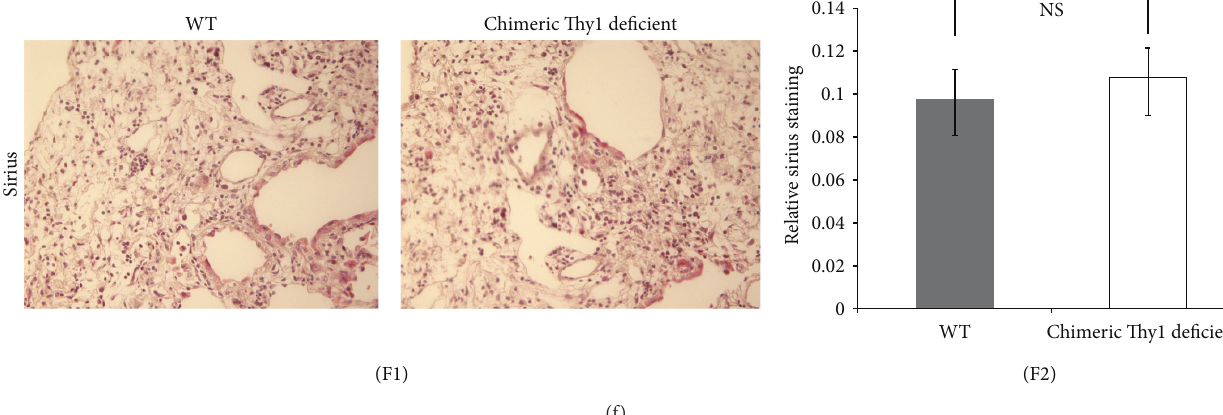
Figure 3: Assessment of fibrotic lung injury following bleomycin intratracheal instillation (IT) in wild-type mice with Thy1 + lymphocytes and Thy1 + myofibroblasts (WT), and chimeric Thy1-deficient mice with Thy1 + WT lymphocytes and Thy1 − myofibroblasts (chimeric). Thy1- deficient mice (DEF) were provided by Prof. R.J. Morris. Chimeric mice were created by whole-body irradiation (750 rad) of the Thy1- deficient mice, followed by transplantation with WT Thy1 + lymphoid cells (chimeric). Wild-type mice underwent whole-body irradiation and reconstitution with WT Thy1 + lymphoid cells as control (WT). (A) Flow cytometry analysis to detect Thy1 + immune cells in Thy1-deficient mice (DEF), wild-type mice (WT), and chimeric Thy1-deficient mice with transplanted WT Thy1 + lymphocytes. Thy1 + immune cells were identified in blood cells by double staining with PE-conjugated anti-Thy1 and FITC-conjugated anti-CD3. (B) Quantitative image analysis of pathological sections in chimeric Thy1-deficient mice (Thy1 + lymphocytes/Thy1– myofibroblasts, empty bars) and control WT mice (grey bars) 14 d following IT bleomycin. 𝑛 = 6 WT and 8 chimeric 2 (C) Analysis of collagen content in lungs using the Sircol assay 14 d following